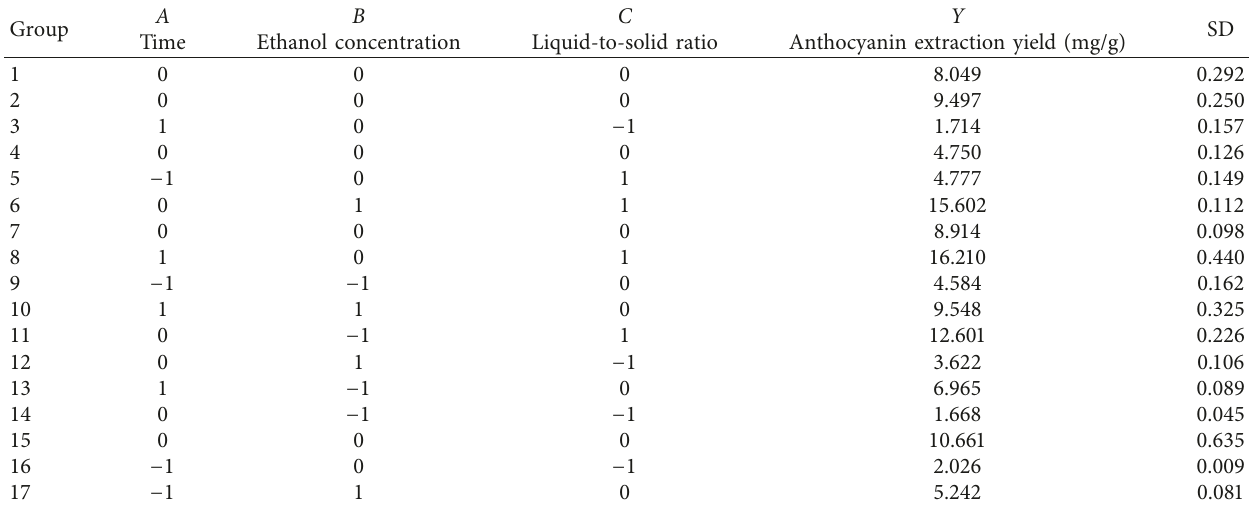
Figure 1: Single-factor experimental analysis of rabbiteye blueberry anthocyanin extraction. The effect of different extraction parameters: (a) hydrochloric acid concentration, (b) ethanol concentration, (c) extraction time, (d) extraction temperature, and (e) liquid-to-solid ratio on the anthocyanin extraction yields. Table 2: Box–Behnken experimental